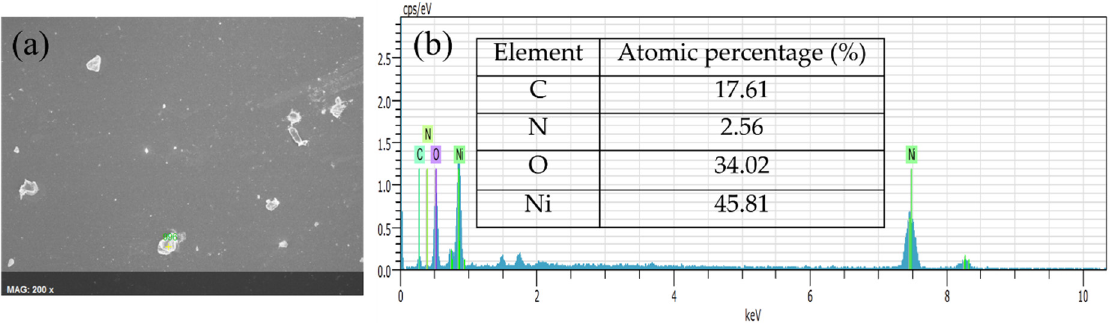
Figure 4. Scanning electron microscopy (SEM) image observation; ( a ) the top view and ( b ) the energy dispersive spectroscopy of APN film. The element’s (C, N, O, and Ni) atomic percentages are also shown in Figure 4b.